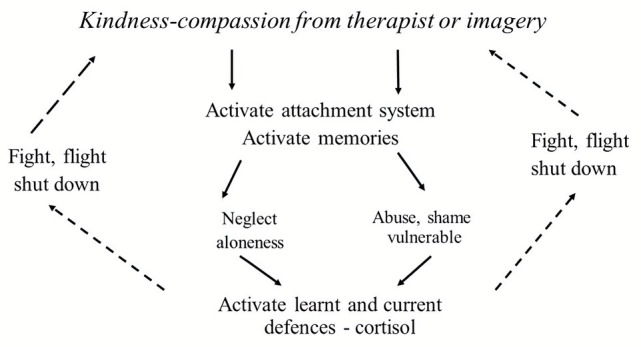
Fears of compassion and attachment history. Adapted from Gilbert (2009b).